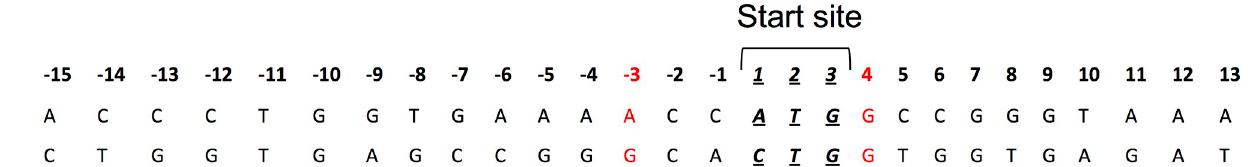
Fig 2. Sequence context around translation start sites. Two example sequence contexts are shown to visualize the definition of the flanking sequence around translation start sites. Per definition, positions around the translation start site are given relative to the start codon, which is denoted as 1,2 and 3. Position zero is left out. Positions -3R (R = purine) and +4G were shown to be crucial for translation initiation [16, 17] and are therefore highlighted in red color.